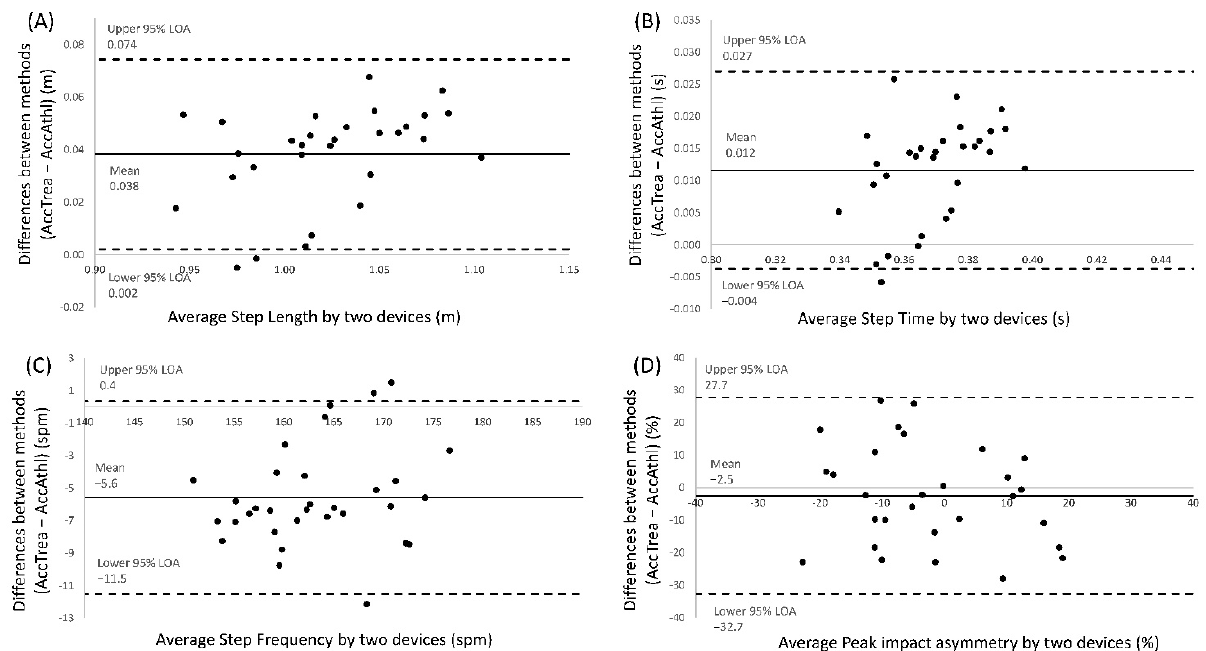
Figure 2. Bland–Altman plots representing comparisons between the AccTrea system and the AccAthl system for four of the variables analyzed: ( A ) Step length; ( B ) step time (duration); ( C ) step frequency; and ( D ) peak acceleration impact asymmetry. The mean line represents the mean difference between the devices, with the upper and lower dashed lines representing the 95% limits of agreement (LOAs).